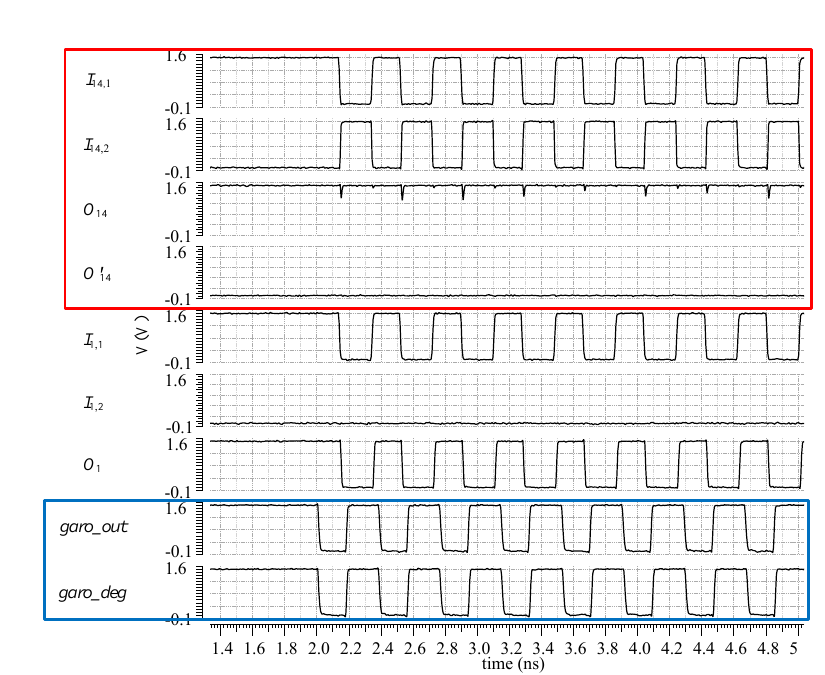
Figure 13: The simulated waveforms with feedback polynomial f ( x ) = x 15 + x 14 + x +